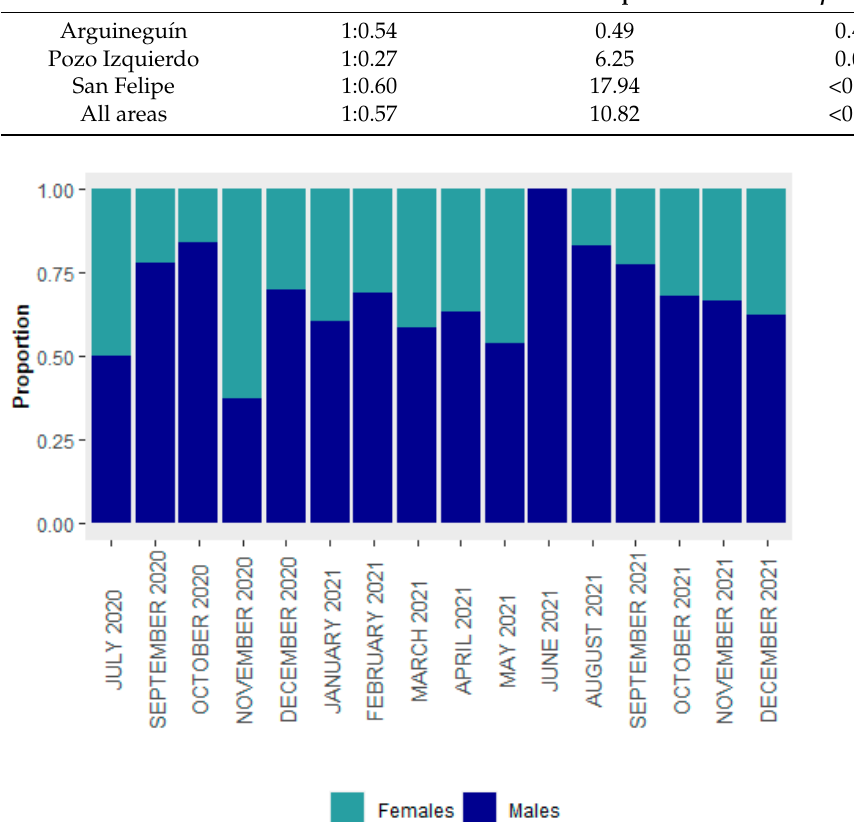
Animals 2023 , 13 , x FOR PEER REVIEW Figure 5. Proportion of Percnon gibbesi females and males caught in intertidal areas of Gran Canaria between July 2020 and December 2021.